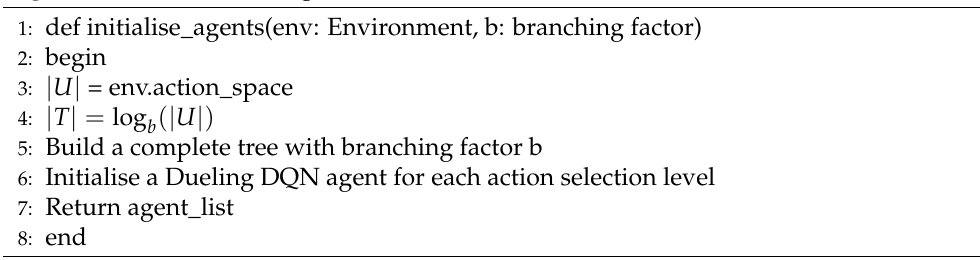
Algorithm 2 Initialise the